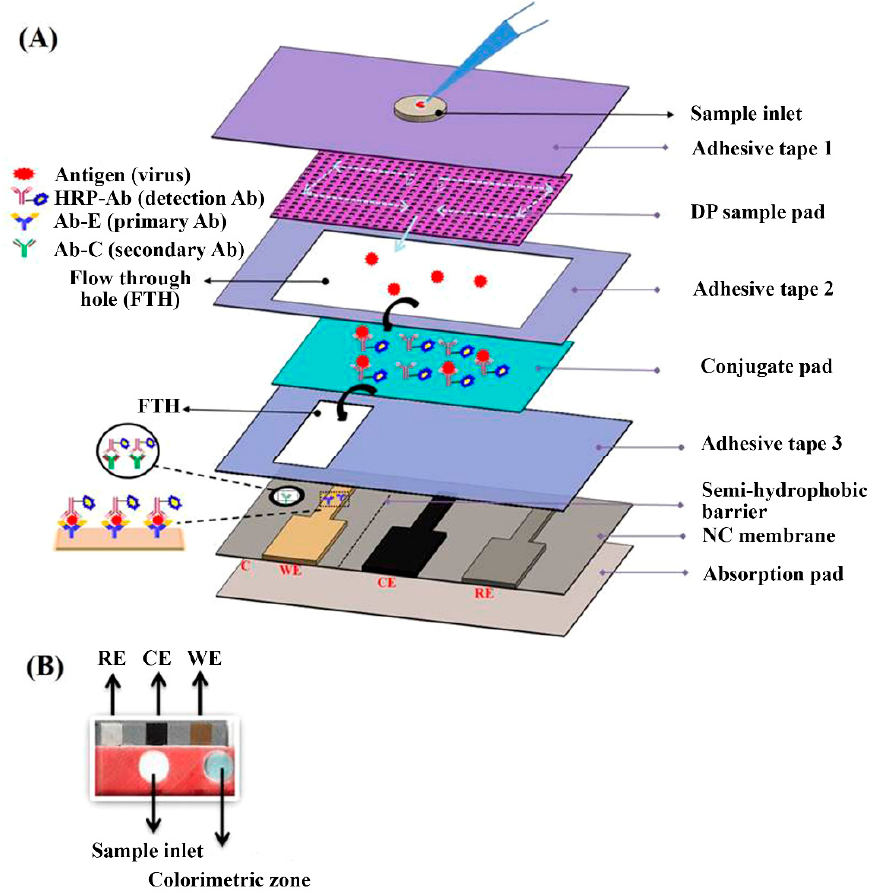
Figure 2. ( A ) Schematics of the integrated vertical flow assay device for dual detection. The sample pad consists of two different pore size papers: the upper one has the larger pore size (11 µ m) and the lower one has the smaller pore size (0.45 µ m). ( B ) Photograph of the VFA device. Adapted from Ref. [65], Copyright (2018), with permission from Elsevier.